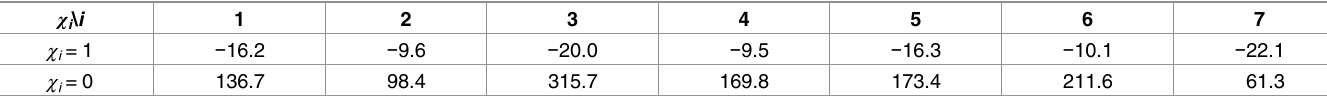
Table 5. M = 7, model 1: Percentages of variation of a downgrading probability. χ i \ i